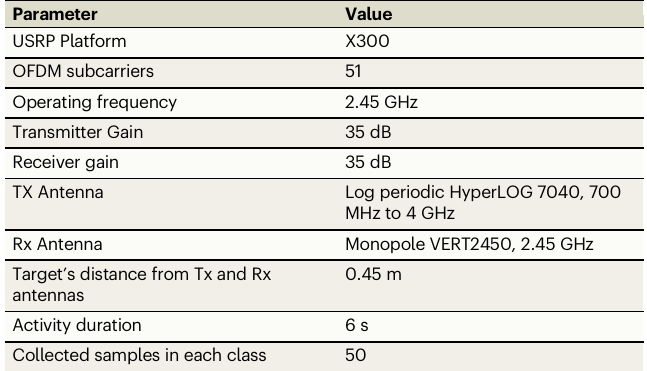
Table 2 | Con fi guration parameters of USRP software and